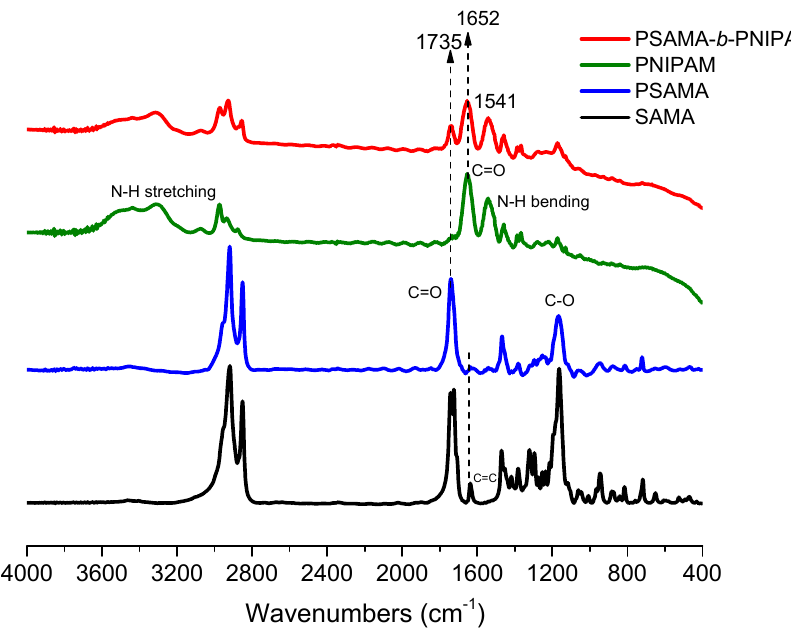
Figure 3. FTIR spectrum of SAMA, PSAMA, PNIPAM and PSAMA- b -PNIPAM.